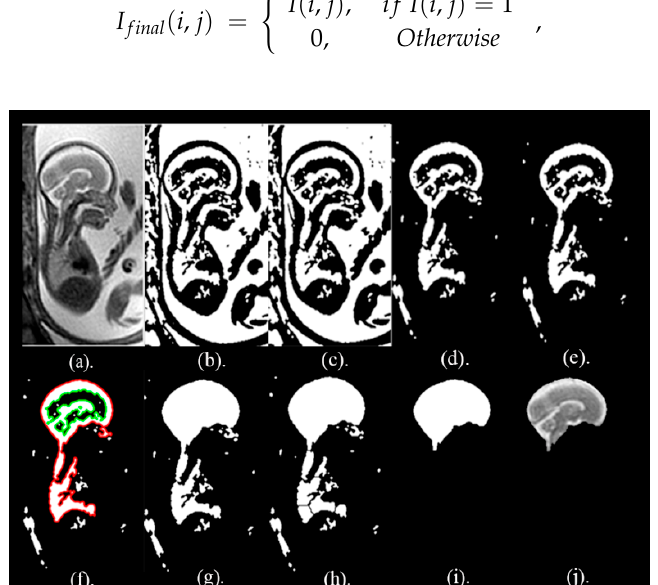
Figure 3. Fetal brain pictures the different steps of the segmentation phase. ( a ) The original fetal brain picture I . ( b ) Binary picture when adaptive thresholding was employed, I binary . ( c ) Binary picture when opening morphological operation was used, I open . ( d ) Binary picture I clear after using clear border process. ( e ) Binary picture when the closing process was made. ( f ) Binary picture presenting the parent boundaries in red and the children in green. ( g ) Binary picture applying the tracing boundary process, I region . ( h ) Binary picture when using watershed approach, I watershed . ( i ) Binary picture when applying